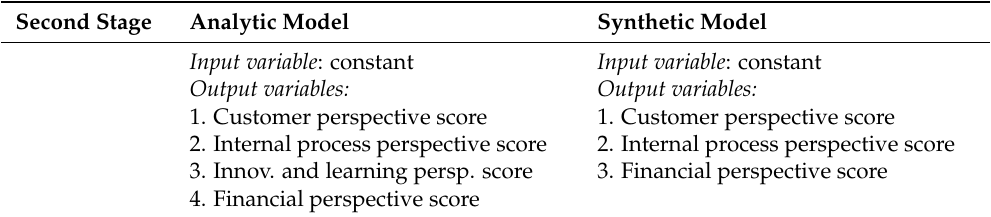
Table 2. Input and output variables of the second stage DEA-BSC